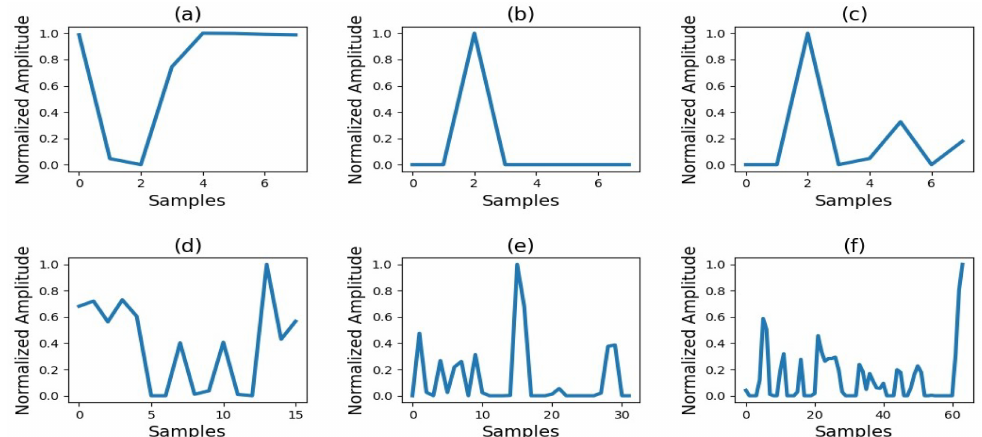
Figure 3. Step-by-step evolution of bottleneck feature maps towards the final respiration signal with the help of attention blocks’ output. Each subplot shows the feature map output of ( a ): bottleneck layer feature map; ( b ): first attention block feature map; ( c ): second attention block feature map; ( d ): third attention block feature map; ( e ): fourth attention block feature map; ( f ): fifth attention block feature map. The features are automatically suppressed or highlighted according to the weights generated by the attention block. The y-axis of each subplot represents the normalized amplitude of the feature maps. The x-axis of each subplot represents the number of samples in each feature map, whereas the last sample represents the feature map size.